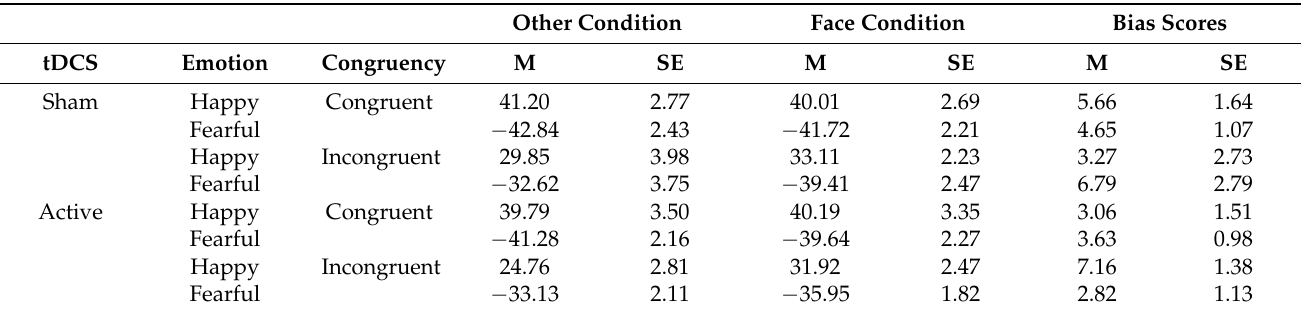
Table 3. Mean emotional ratings and bias scores for all Other and Face conditions in the SOFE task in dependance of own emotional ratings in the Self condition (Emotion) and their congruence with the Face condition (Congruency). Note that bias scores were categorized as either egocentric (positive scores) or non-egocentric (negative scores) on a trial-by-trial